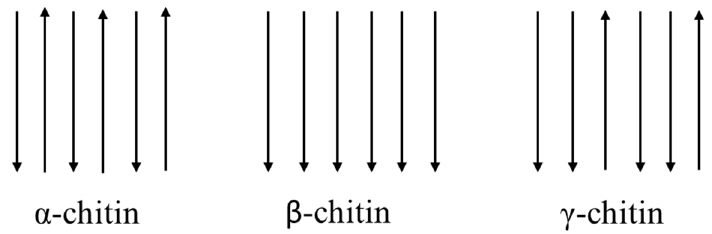
Figure 2. Representation of the three allomorphic forms of chitin in Figure 2 . Representation of the three allomorphic forms of chitin in nature.